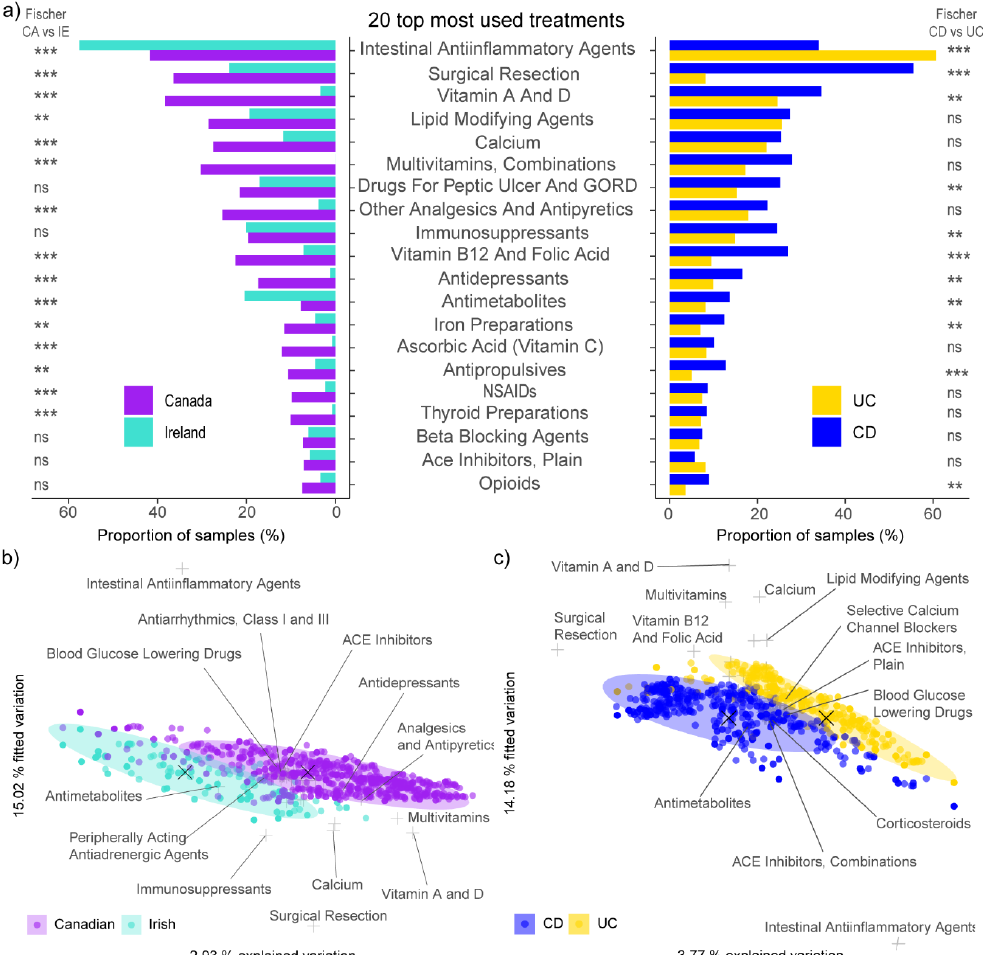
Figure 3. Comparison of the 20 most common medications and supplements taken in the study cohort separated by IBD-subtype and geographic location ( a ). Ordination plot of Jaccard distance-based redundancy analysis (dbRDA) of used medications and supplements constrained by ( b ) geographic location and ( c ) IBD-subtype. The points represent samples, crosses represent medications and X represent the centroids of the depicted groups. The 5% of medications with the best axis fit are labelled; Fishers test: ns p > 0.05; ** p < 0.01; *** p < 0.001. The participant groups from varying locations and with a different disease type not only diverged in their drug usage pattern, but also in the amount of ingested pharmaceu- tical compounds. Overall, persons with CD took a significantly higher number of supple- ments and medications (Wilcox p < 0.05) than persons with UC. Similarly, Canadian par- ticipants used a significantly greater number of supplements and medications than their Irish counterparts (Figure 4a,b). Another source of variation between the groups was the frequency with which specific medications were changed over the course of the study. Only 73 of 349 participants did not change their medication regime during the 6 months of study, while another 93 persons changed five or more medications over the three time points (Figure 4c). Unsurprisingly, due to the higher usage of pharmaceutical products in the Canadian cohort, there were also significantly (Wilcox p < 0.05) more changes of med- ications in this group, while there were no significant disparities between persons with UC and CD within their cohort (Figure 4d).